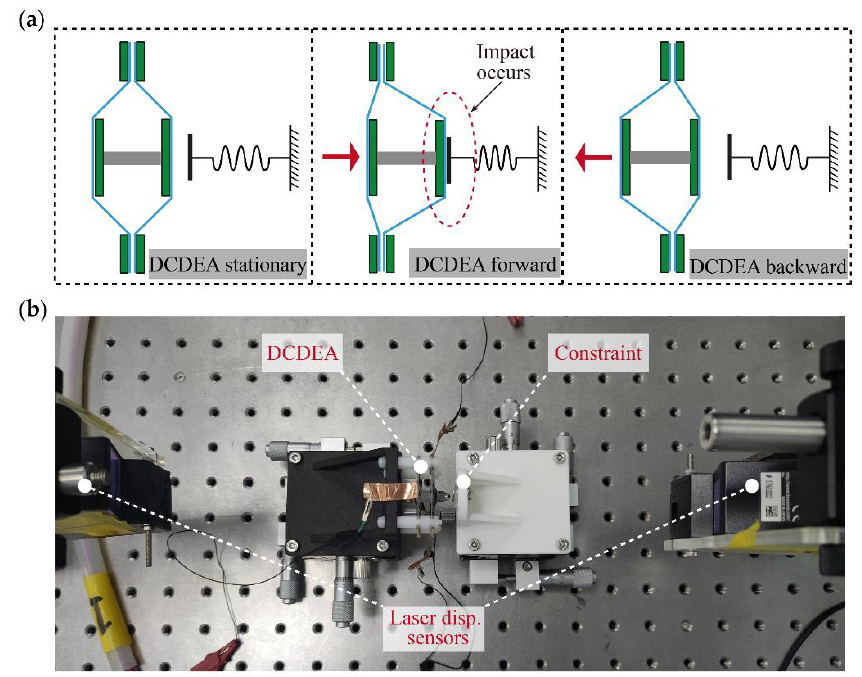
Figure 2. ( a ) Illustration of the DCDEA-based vibro-impact system and ( b ) experimental setup for the DCDEA dynamic test.